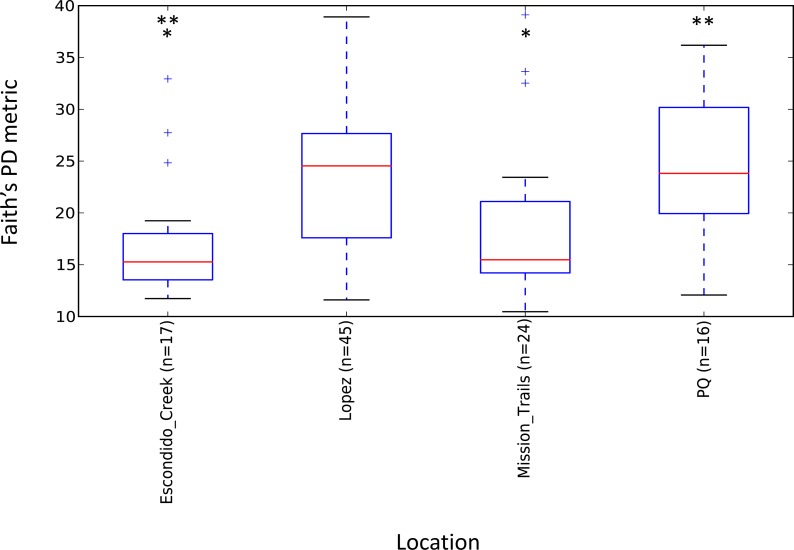
Boxplot of microbiome alpha diversity in D. occidentalis ticks measured by Faith’s phylogenetic diversity (PD) whole tree as implemented in QIIME of four different hiking areas in San Diego County.Stars indicate statistically significant differences between samples; Faith’s PD, two sample t-test, Escondido Creek versus Lopez Canyon; t =  − 3.28, P = 0.02; Escondido Creek versus PQ, t =  − 3.31; P = 0.04; other comparisons were not statistically significant. PQ = Peñasquitos Canyon.